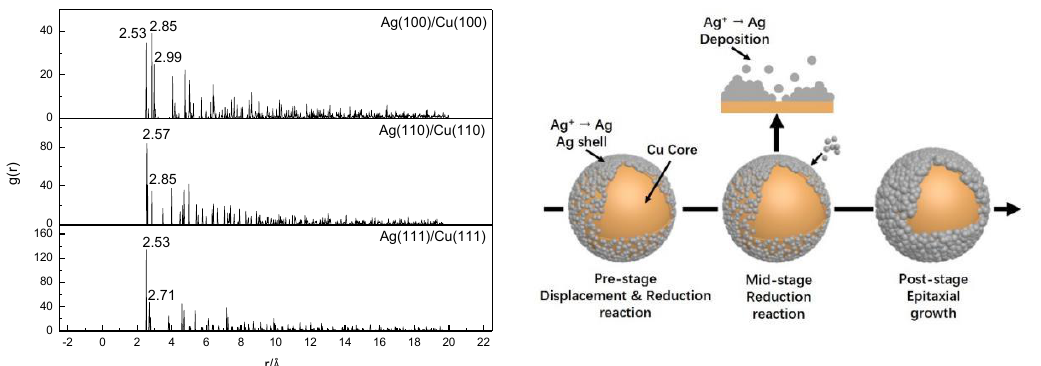
Figure 5. The radial distribution function of interface and the three-dimensional schematic diagram.